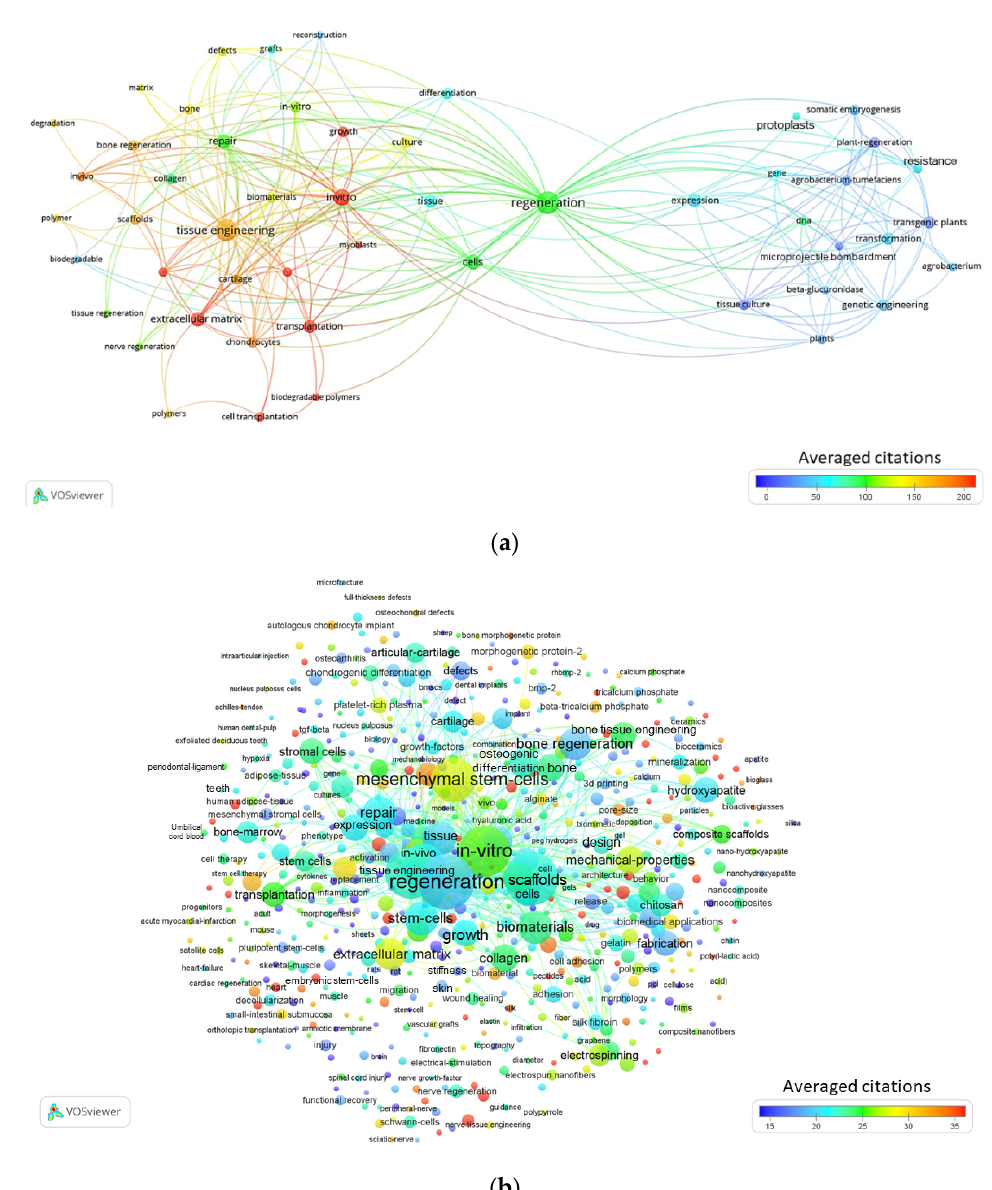
Figure 2. Term map for years ( a ) 1990 through 1999 ( b ) 2010 through 2019. ( a ) Term map showing the visualization of 51 terms. Table S1 contains all the terms visualized with their respective occurrence frequencies and averaged citations. ( b ) Term map showing the visualization of 630 terms. Table S3 contains all the terms visualized with their respective occurrence frequencies and averaged citations.